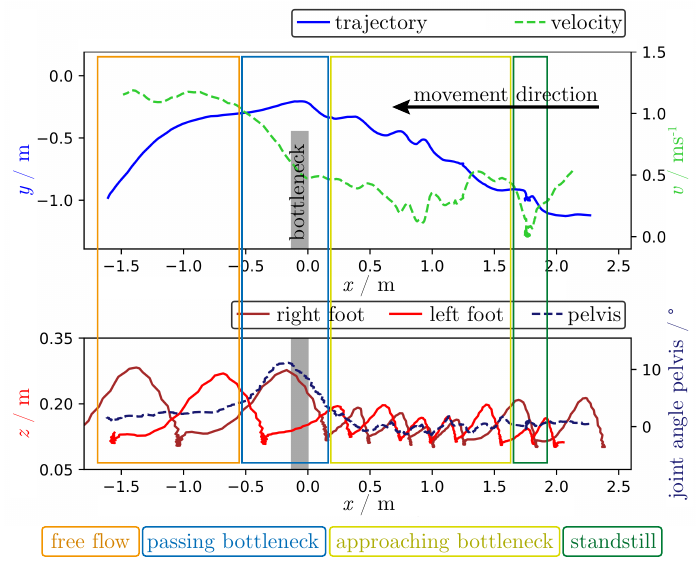
Figure 8. Trajectory of the head position in xy -plane (blue curve), velocity (dashed green), foot position in xz -plane (dark red for right and light red for left foot) and joint angle of pelvis (dashed dark blue) for a bottleneck experiment of w = 0.9m width and high motivation, h0. The person wearing the MoCap system moved from right to left. Phases within the experiment marked with rectangles: standing still (green), stagnant movement to the bottleneck entrance with small steps (yellow), crossing the bottleneck (shown as a gray rectangle) with a rotated pelvis (cyan) and free flow with larger steps and free flow velocity after passing through the bottleneck (orange). A gray rectangle starting at x = 0 indicates the position of the bottleneck. The upper diagram visualizes only the lower part of the experimental area so that only one side of the bottleneck wall can be